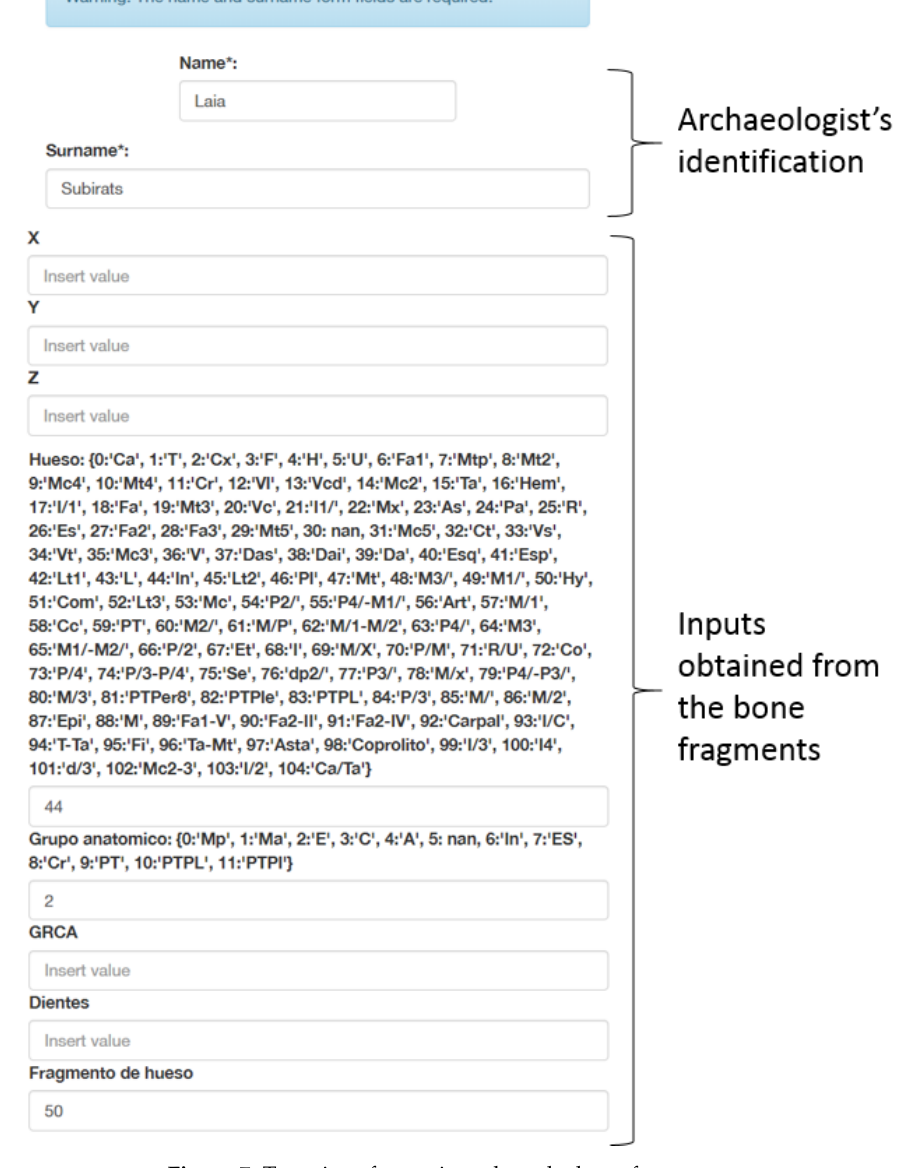
Figure 7. Tutor interface to introduce the bone